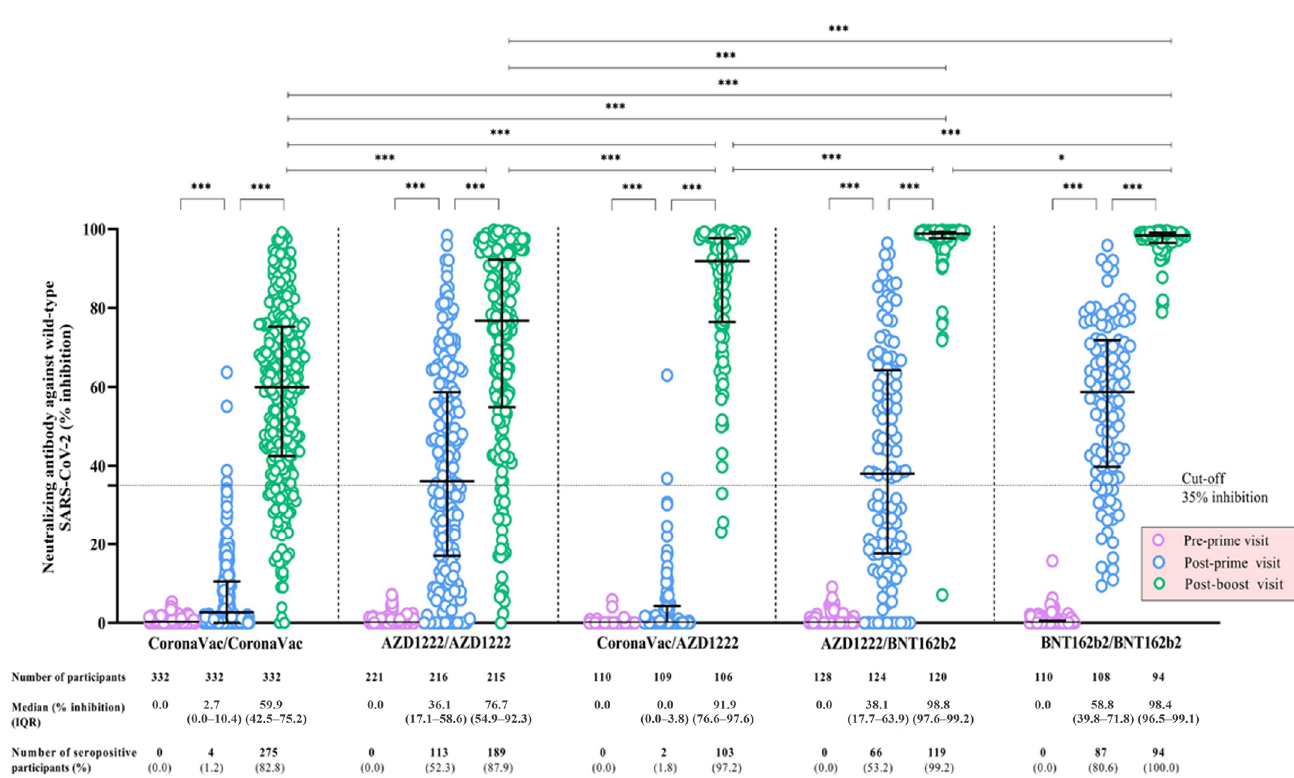
Figure 2. Neutralizing antibody against wild-type SARS-CoV-2 following a primary series of COVID-19 vaccination, stratified by the COVID-19 vaccine regimen. Data points are the reciprocals of individual participants. The median values of neutralizing antibodies (NAb) and the corresponding interquartile ranges (IQR) against wild-type SARS-CoV-2 among all participants at the pre-prime, post-prime, and post-boost visits are shown as black solid lines. Black dotted lines indicate the cut-off values. The Wilcoxon signed-rank test was performed to compare the medians of NAb against wild-type SARS-CoV-2 between visits within each COVID-19 vaccine regimen. The median regression analysis was performed to compare the medians of NAb against wild-type SARS-CoV-2 between COVID-19 vaccine regimens. * indicates p < 0.05; and *** indicates p < 0.001 for the comparison of NAb against wild-type SARS-CoV-2 between visits within each vaccine regimen and between indicated vaccine regimens. Abbreviations: AZD1222 vaccine, the Oxford-AstraZeneca COVID-19 vaccine; BNT162b2, Pfizer-BioNTech vaccine; COVID-19, coronavirus disease 2019; IQR, interquartile range; NAb, neutralizing antibody; SARS-CoV-2, severe acute respiratory syndrome coronavirus-2.